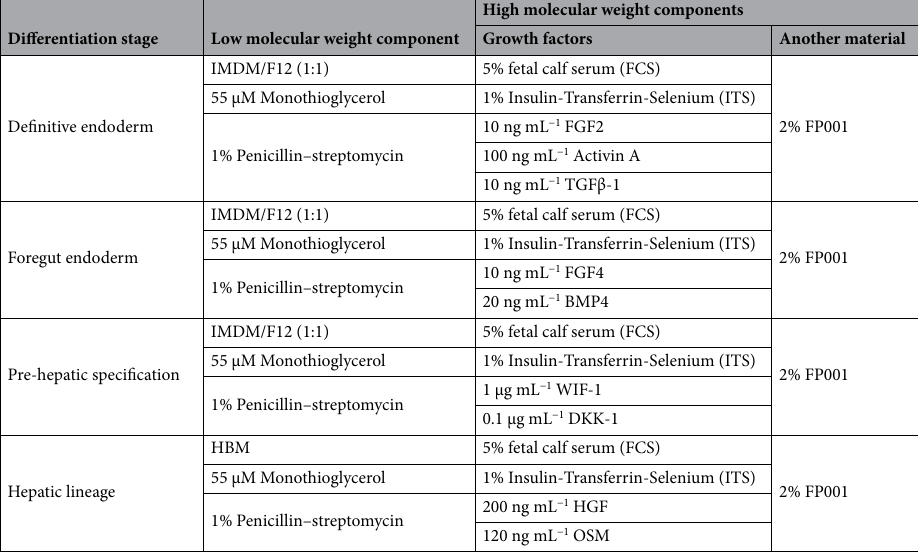
Table 1. The composition of low- and high-molecular-weight components in this